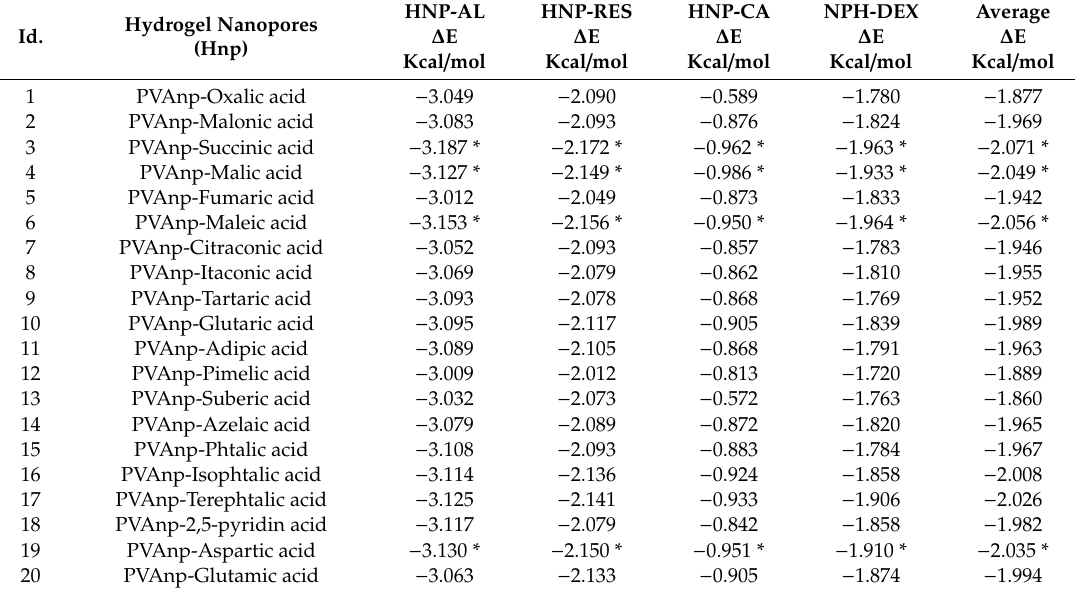
Table 2. Interaction energy values calculated using SQM methods between the hydrogel nanopores (Hnp) and the di ff erent compounds